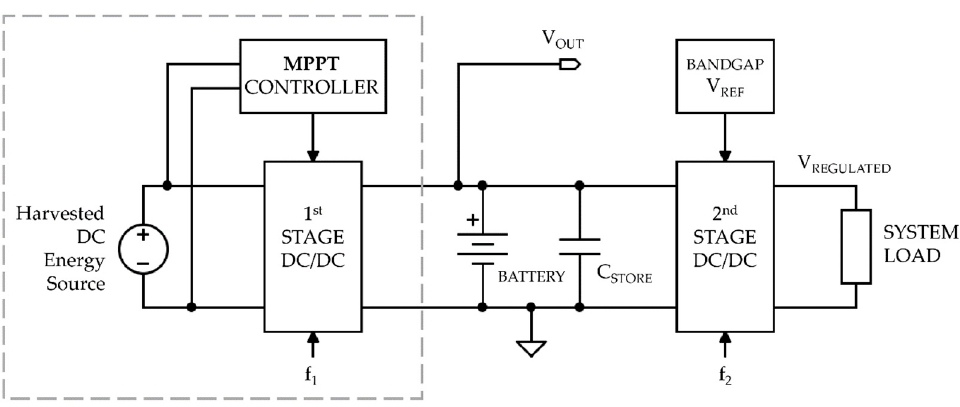
Figure 4. An example of a complete energy harvesting power management system with cascaded maximum power point track (MPPT) and fixed voltage regulated DC/DC converters.